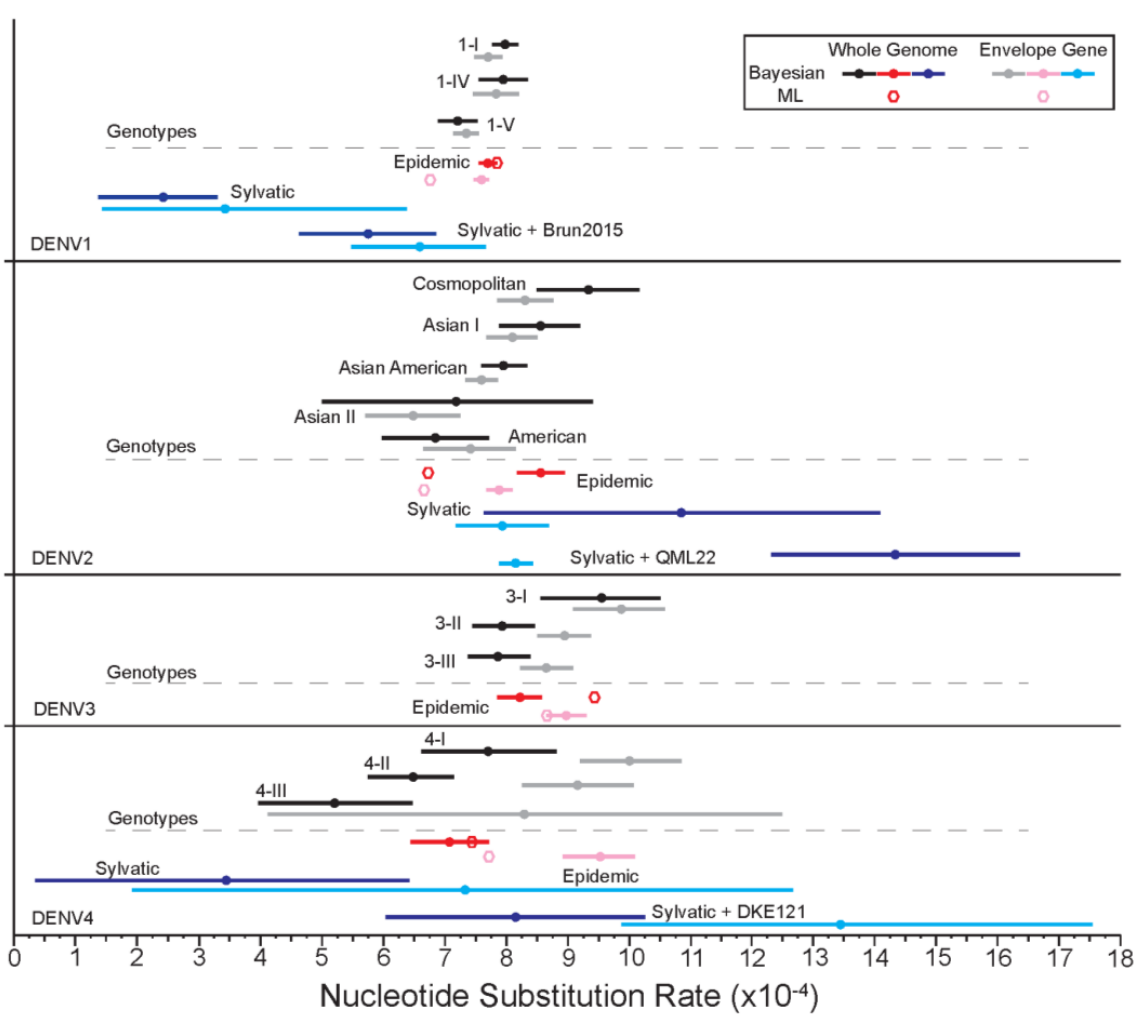
Figure 6. Bayesian estimates of nucleotide substitution rates ( × 10 − 4 /site/year), increasing from left to right, along with corresponding 95% CI for the envelope (E) gene and whole genome for each serotype. ML point estimations for epidemic isolates are represented by hexagons. Estimates were calculated separately for genotype groupings (black/grey), epidemic isolates (red/pink), sylvatic isolates (dark blue/light blue), and sylvatic and highly divergent sylvatic isolates (dark blue/light blue), within each serotype.